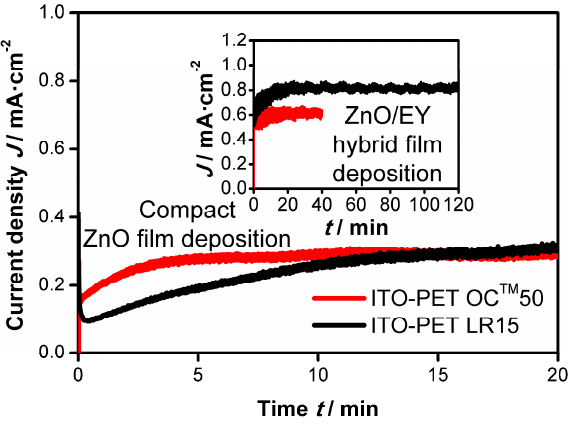
Figure 4. Comparison of current-time behavior during the electrodeposition of compact ZnO films (full scale) and subsequent ZnO/EY hybrid films (inset) on ITO-PET substrates OC™50 (at − 0.93 V vs. the rest potential vs. Ag/AgCl) and LR15 (at − 0.95 V vs. the rest potential vs. Ag/AgCl) in the miniplant setup.